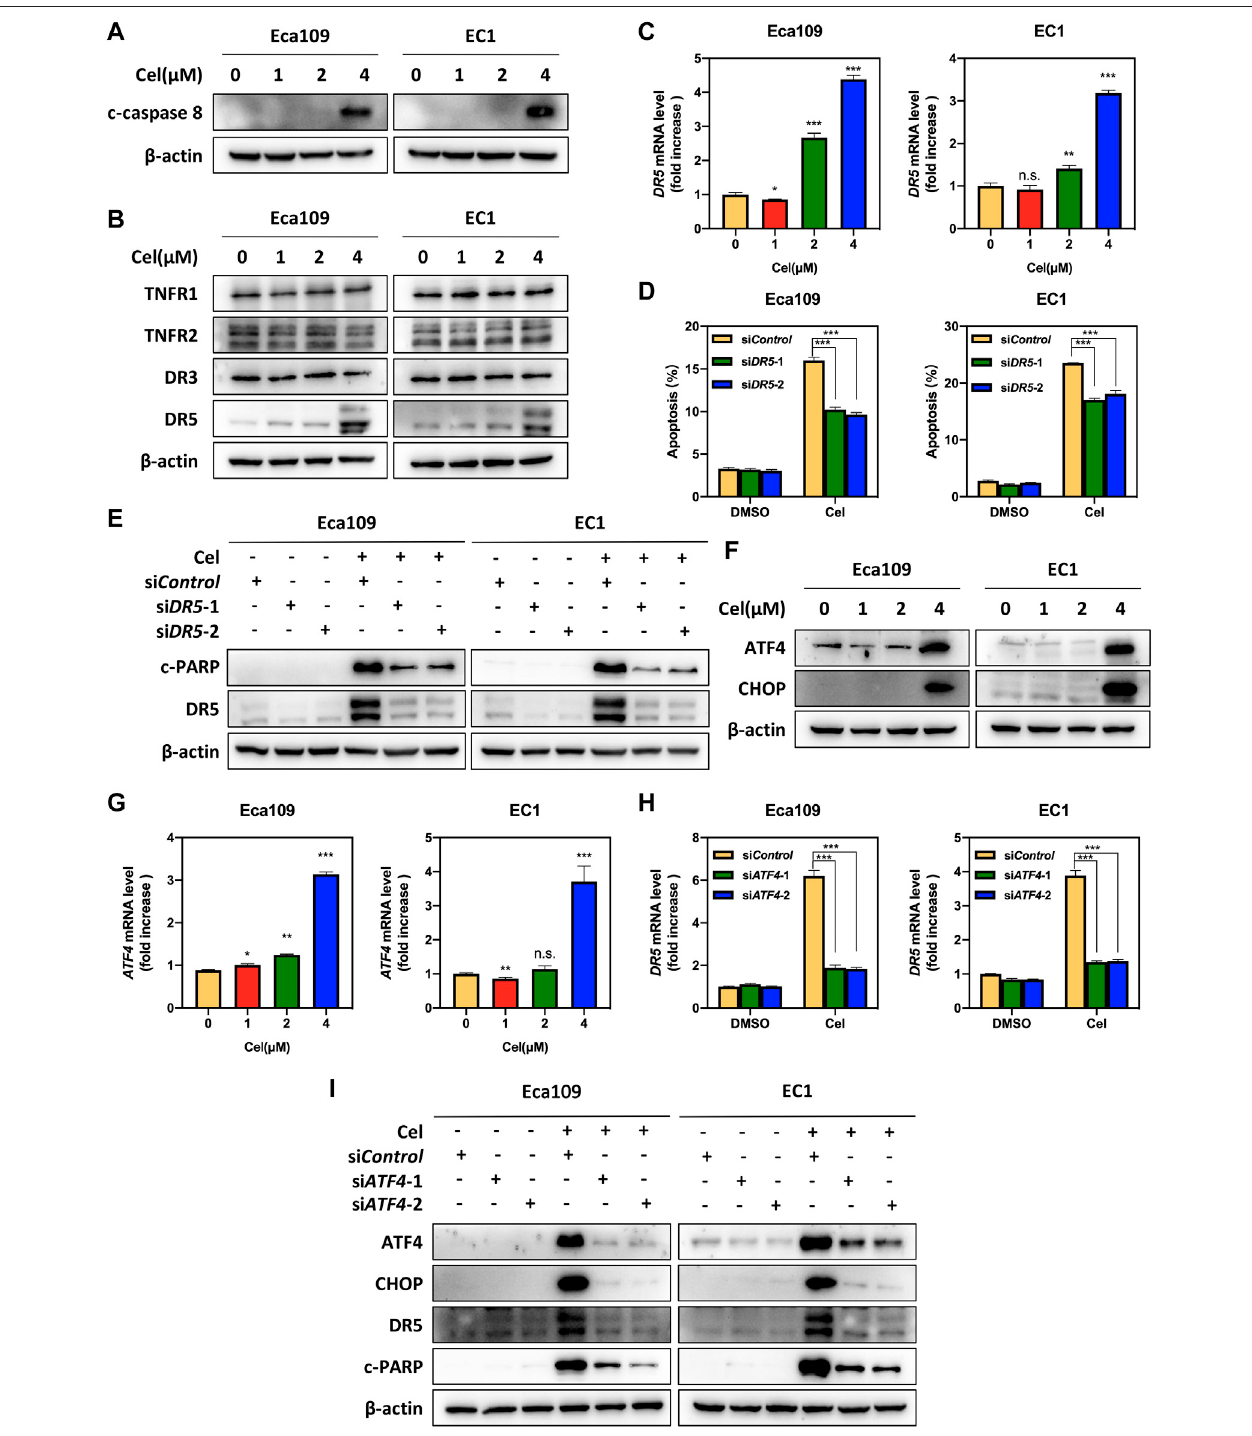
FIGURE3| Celastrolactivated DR5-dependentextrinsicapoptosisbyupregulating ATF4. (A) Celastrolinducedtheactivationofcaspase8.Eca109andEC1 cells were treated with 1, 2, and 4 μ M ofcelastrol or DMSO for 24 h, and cell lysates were analyzed by Western blotting using a speci fi c antibody against c-caspase 8 with β - actinasaloadingcontrol. (B) CelastrolactivatedextrinsicapoptosisbyupregulatedDR5.Eca109andEC1cellsweretreatedwith1,2,and4 μ MofcelastrolorDMSOfor 24 h, and cell lysates were analyzed by Western blotting using speci fi c antibodies against TNFR1, TNFR2, DR3, and DR5 with β -actin as a loading control. (C) Celastrol increased the mRNA level of DR5 . Eca109 and EC1 cells were treated with 1, 2, and 4 μ M of celastrol or DMSO for 24 h, and the mRNA level of DR5 was determined by the real-time PCR. (D,E) Knockdown of DR5 inhibited apoptosis induced by celastrol. Eca109 and EC1 cells were transfected with control or si DR5